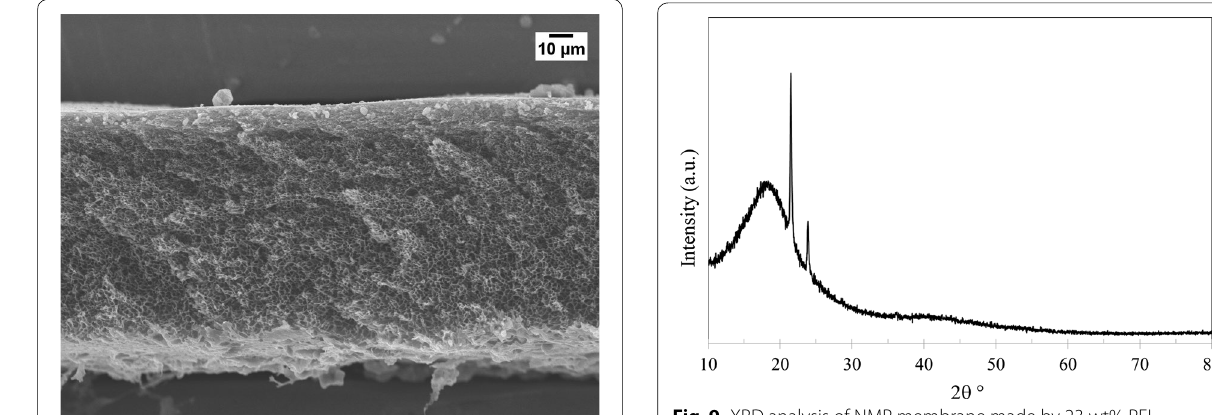
Fig. 9 XRD analysis of NMP membrane made by 23 wt% PEI